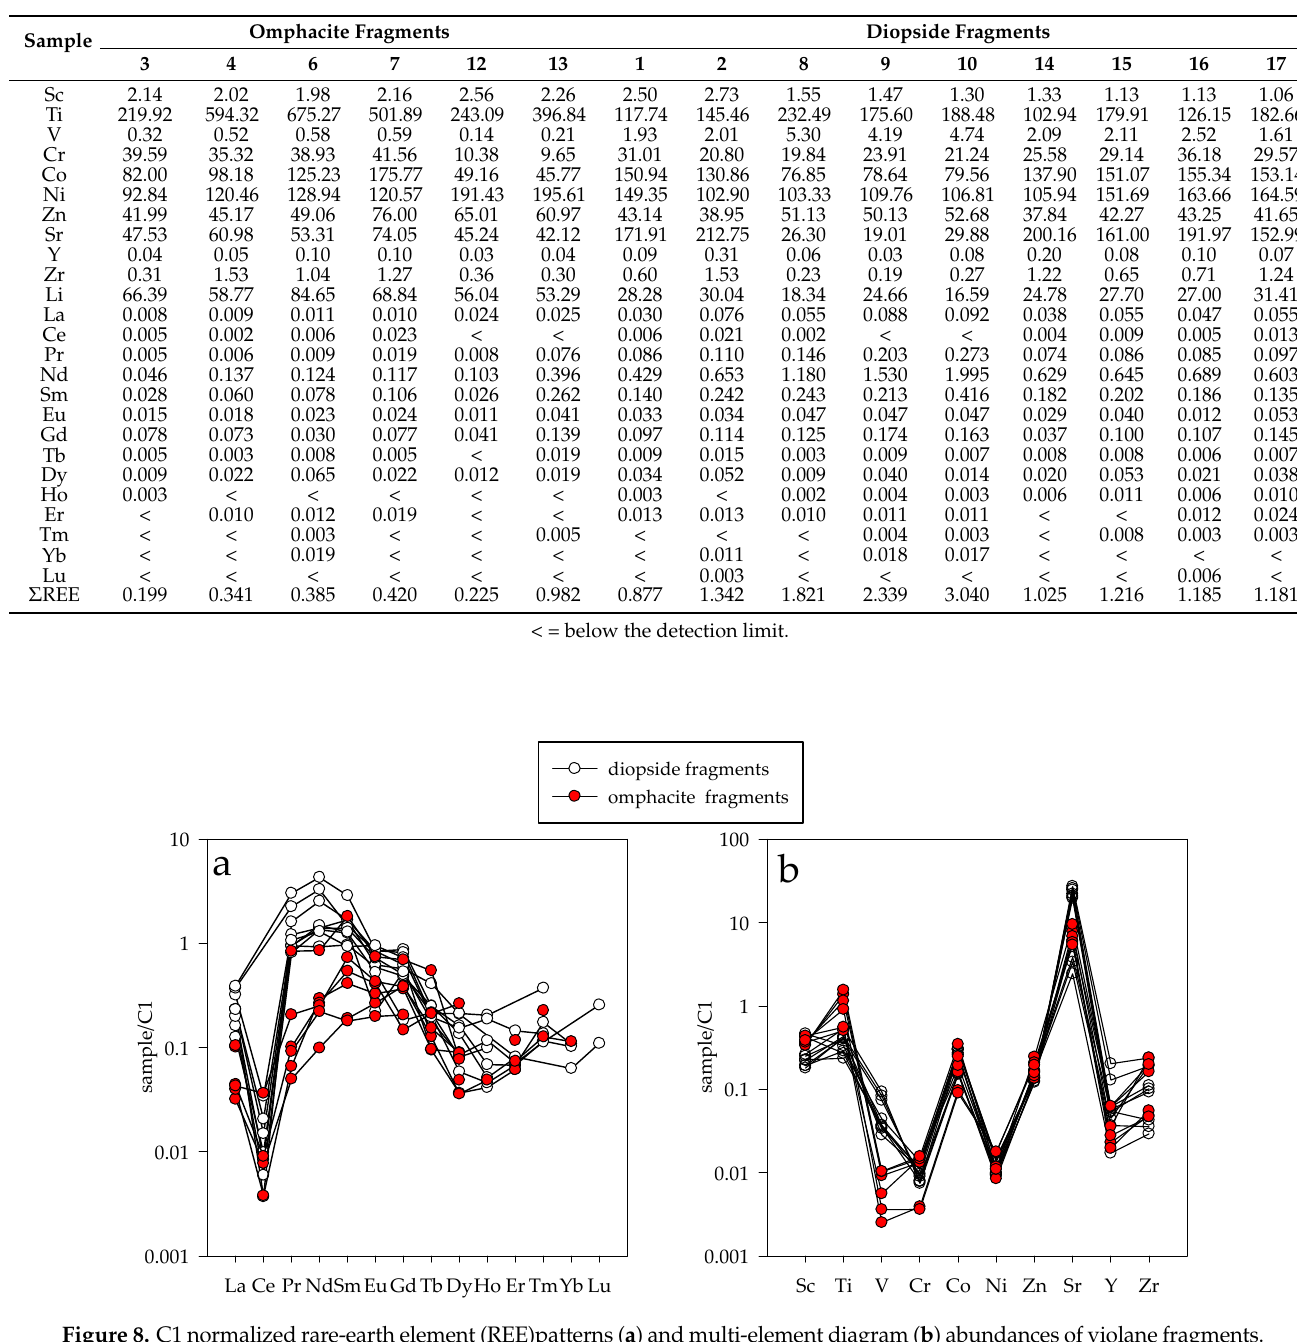
Table 3. Laser-ablation inductively coupled plasma mass spectroscopy (LA–ICP–MS) analyses of the fragments (average of two points for each fragment, ppm).